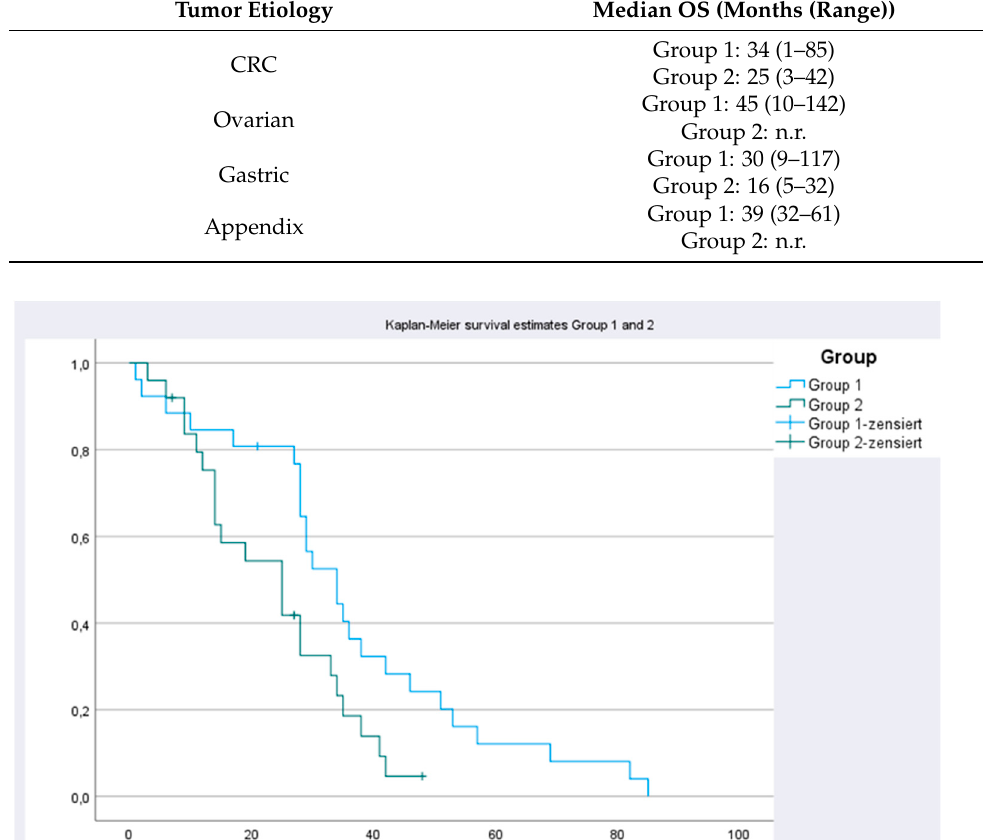
( p = 0.183). Furthermore, in CRC for both groups, the CC score (CC-0 vs. CC-1), grading (G2 vs. G3) and lymphonodal status (N0 vs. N1 vs. N2) did not significantly impact overall survival,